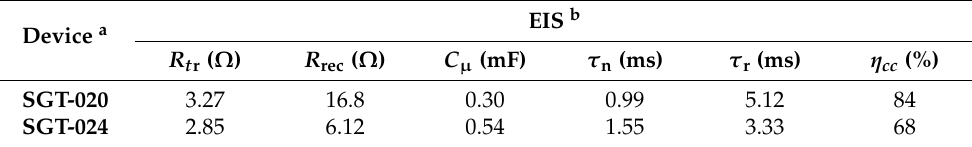
Table 3. EIS data for the SGT-020 - and SGT-024 -based DSSCs. Device